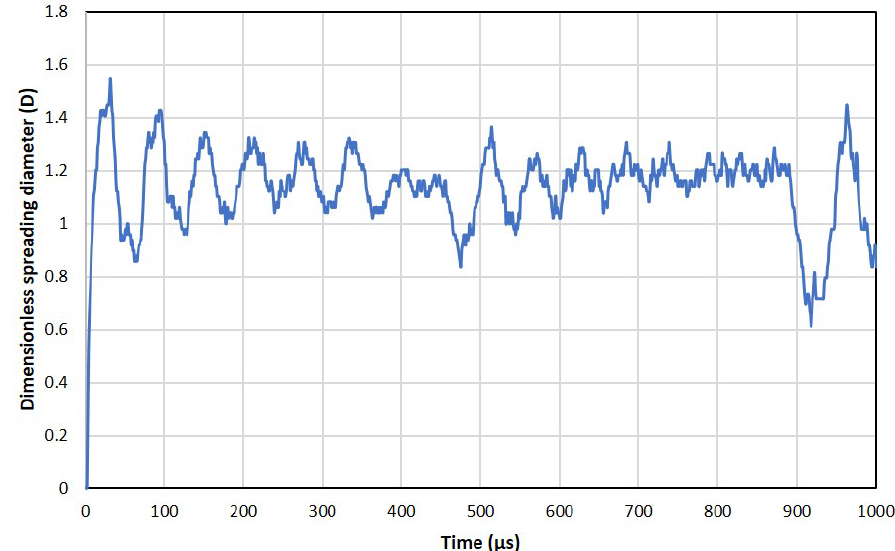
Figure 10. Droplet oscillation via simulation of single-droplet impingement at a velocity of 1 m / s onto a stationary wall.